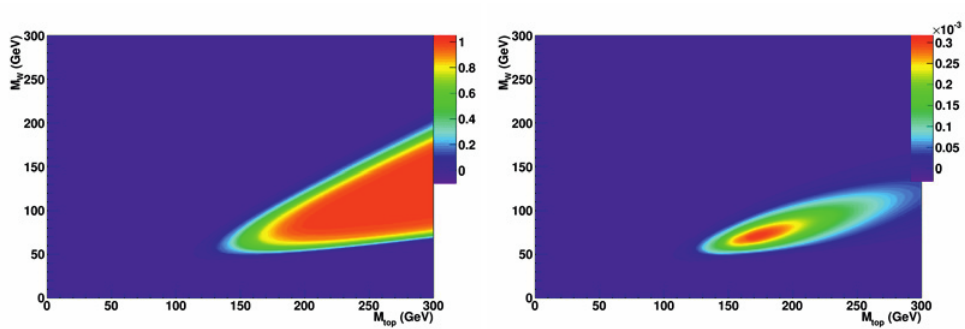
Figure 2. (Left): Solvability (for the correct solution) of 300 test events produced from the same single event by smearing of the momenta of leptons, jets and transverse missing energy. (Right): Average weighted solvability for the same test events normalized to unit